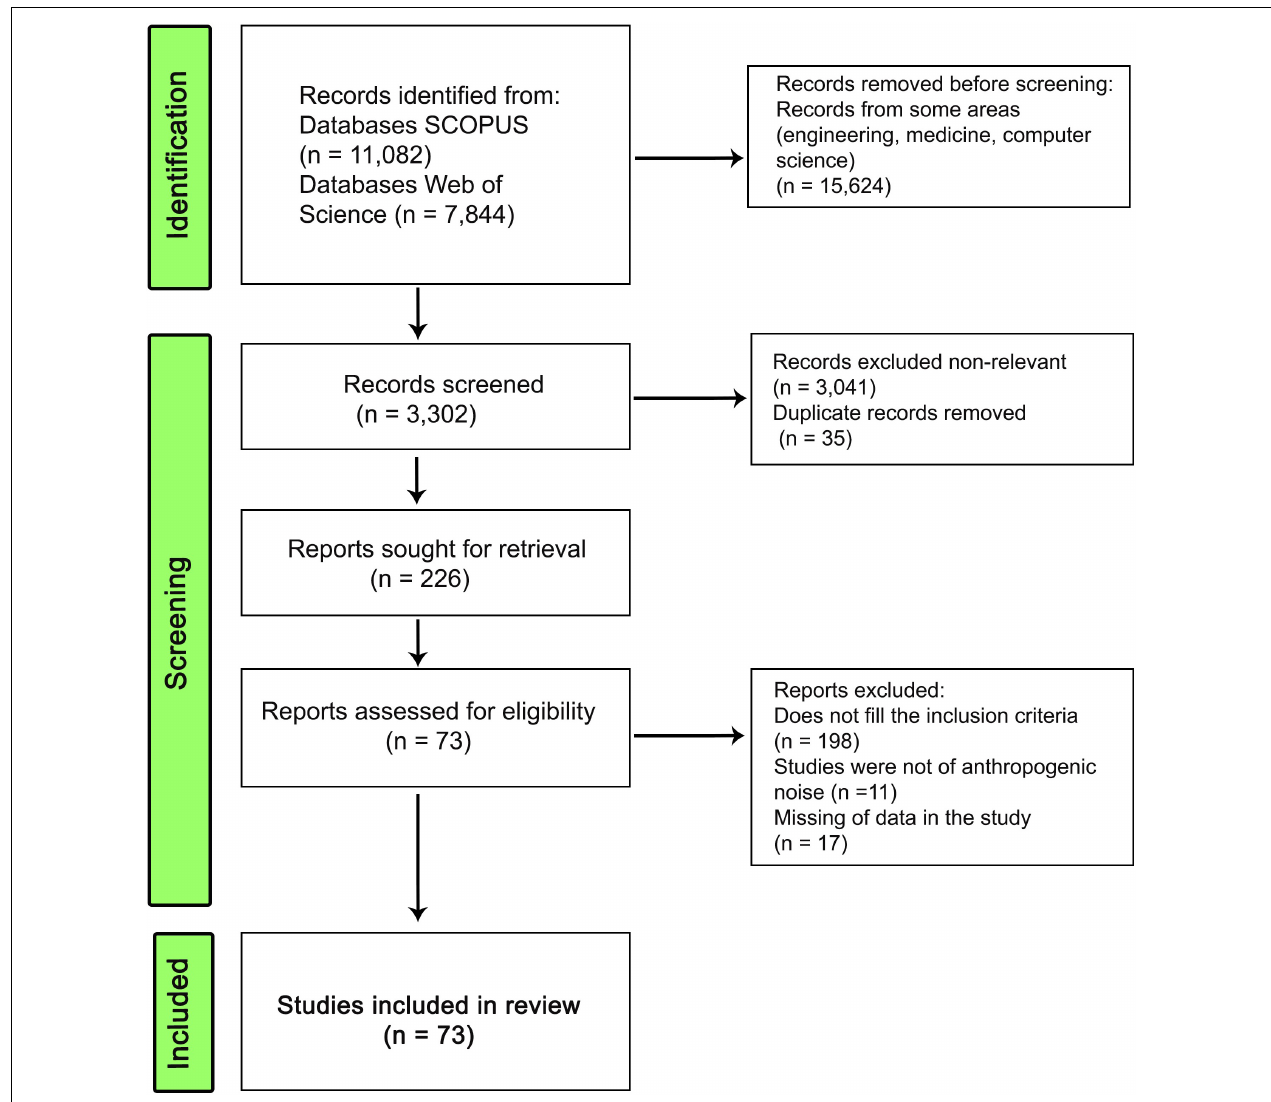
FIGURE 1 | PRISMA flow diagram used for research of scientific articles for the